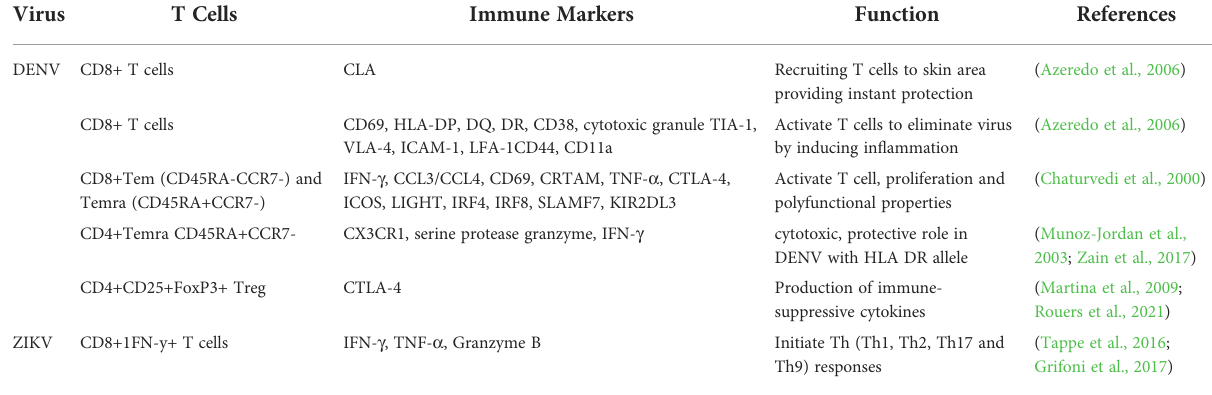
TABLE 2 Host adaptive immunity against DENV and ZIKV. Virus T